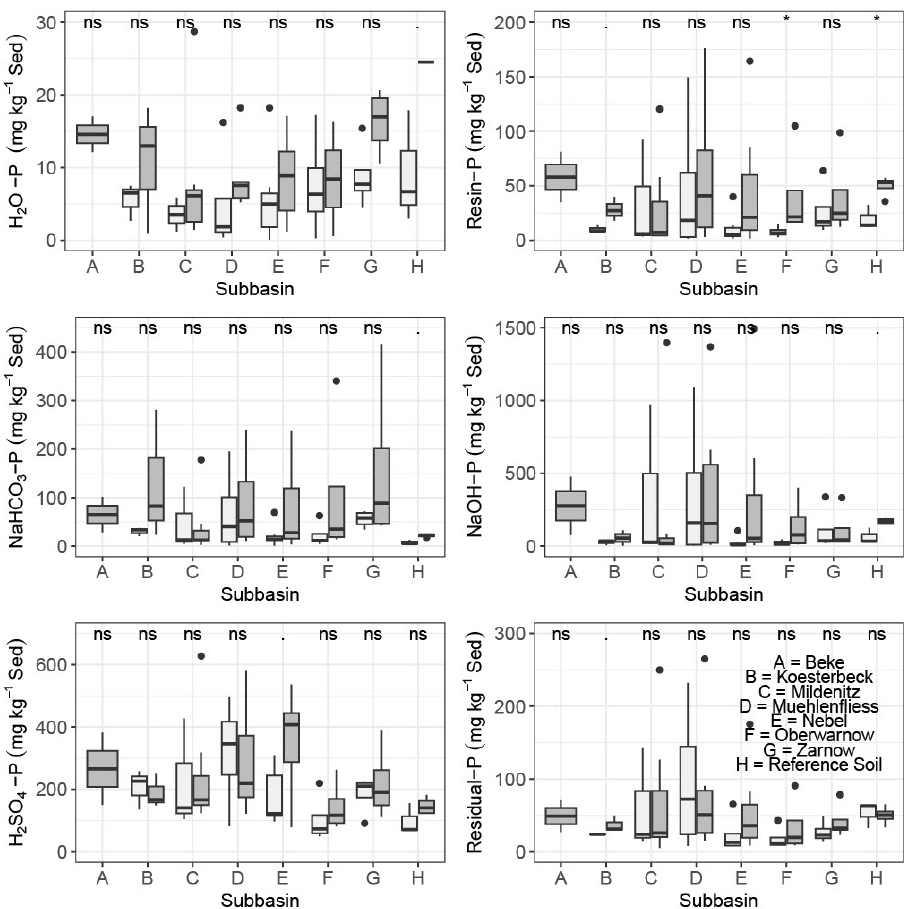
Figure 5. Phosphorus fractions for each subbasin from 0–2 cm (light-colored boxes) and 2–10 cm (dark-colored boxes). Levels of significance are · 0.1, ns = no significance Note the varying y -axis. Black dots are values exceeding 1.5 times the inner quartile range.